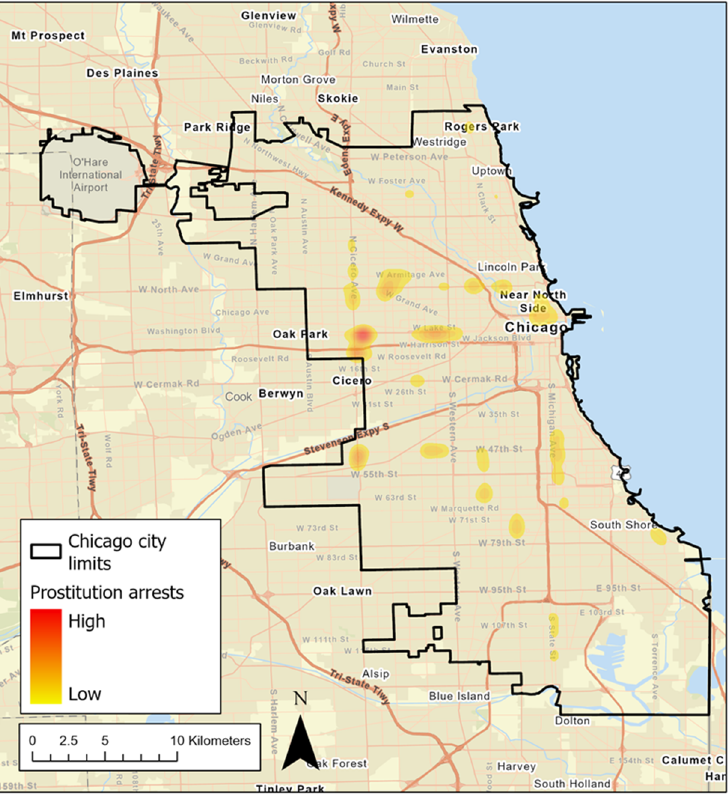
Figure 1. A kernel density map of prostitution arrests from 2009–2016 in